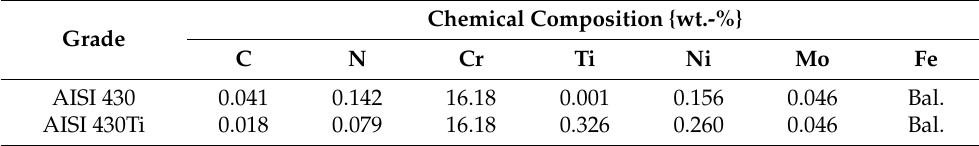
Table 1. Chemical composition of the materials used in the present study. Provided by material supplier. Chemical Composition {wt.-%} Grade C N Cr Ti Ni Mo Fe AISI 430 0.041 0.142 16.18 0.001 0.156 0.046 Bal. AISI 430Ti 0.018 0.079 16.18 0.326 0.260